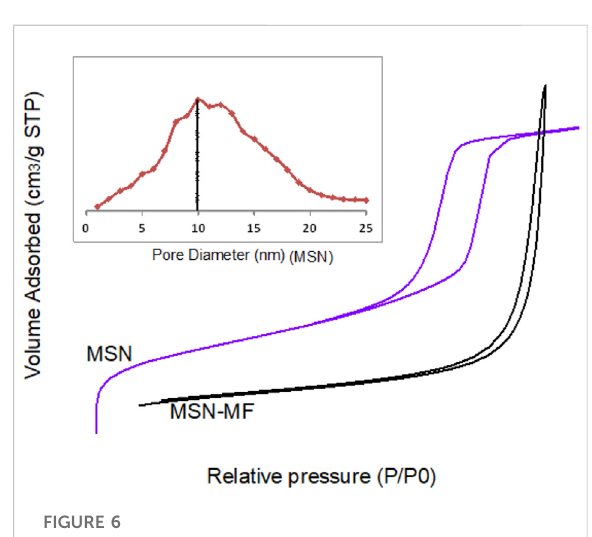
FIGURE 6 Nitrogen adsorption/desorption isotherms of blank MSN and